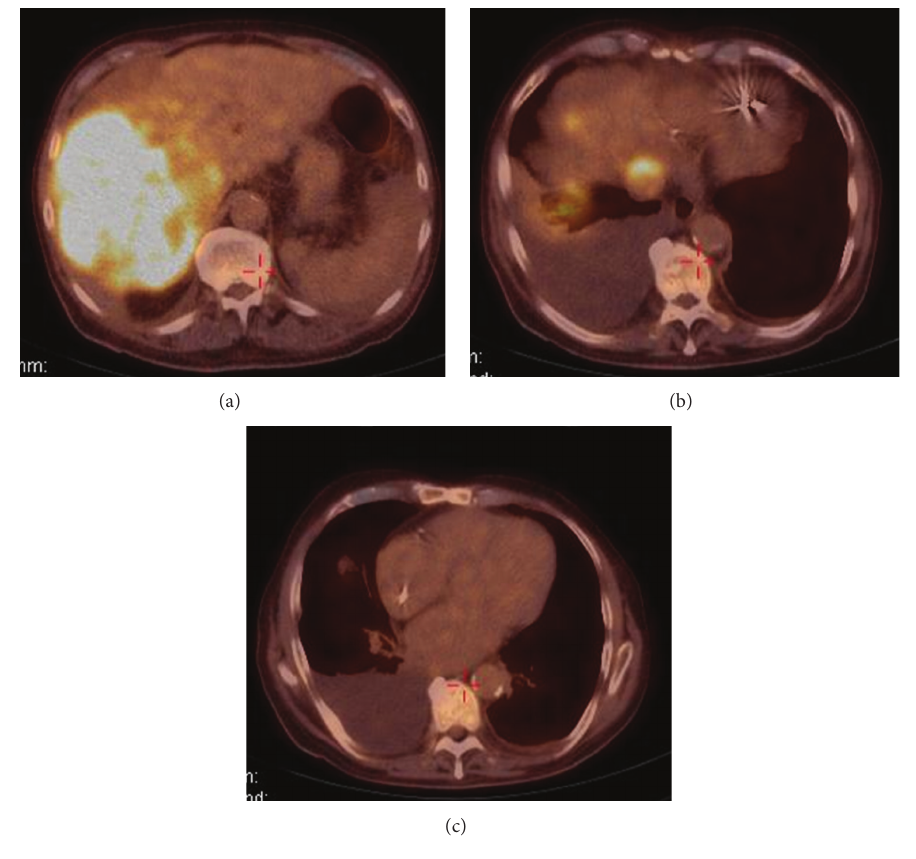
Figure 3: Positron emission tomography-CT.